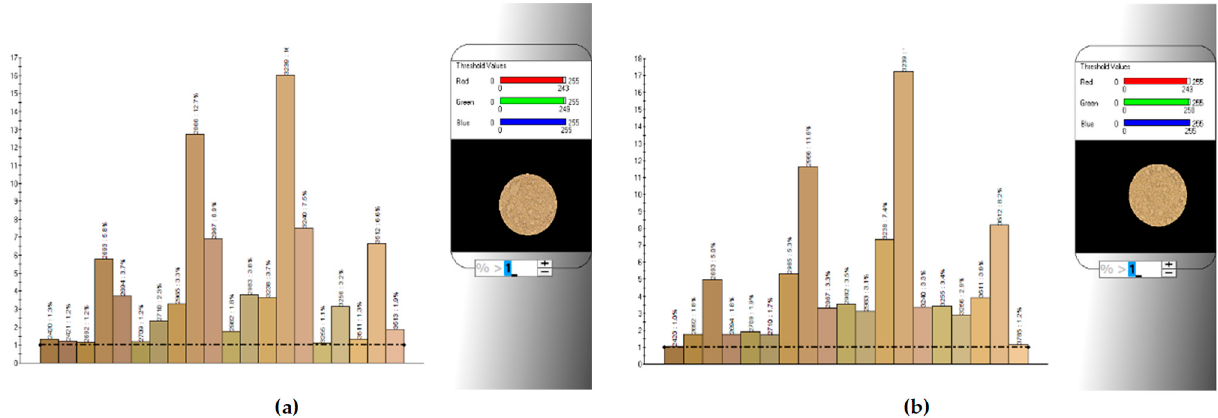
Figure 4. Graphical interpretation of the color distribution of powder obtained from rambutan seed using the instrumental method (‘electronic eye’); ( a ) CD powder; ( b ) FD powder. Table 2. Color parameters in the L*a*b* space of mango and rambutan seed powders obtained by different drying methods.